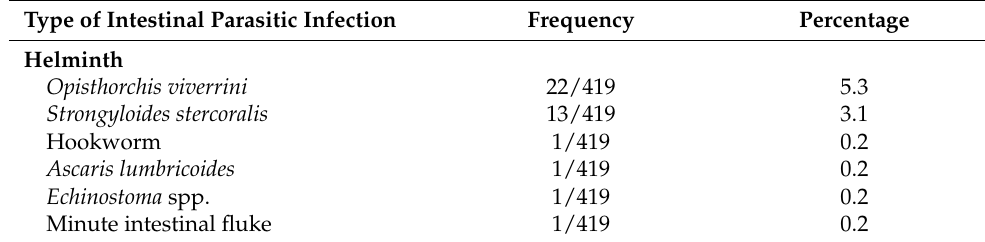
Table 2. The intestinal parasitic infections among participants in the